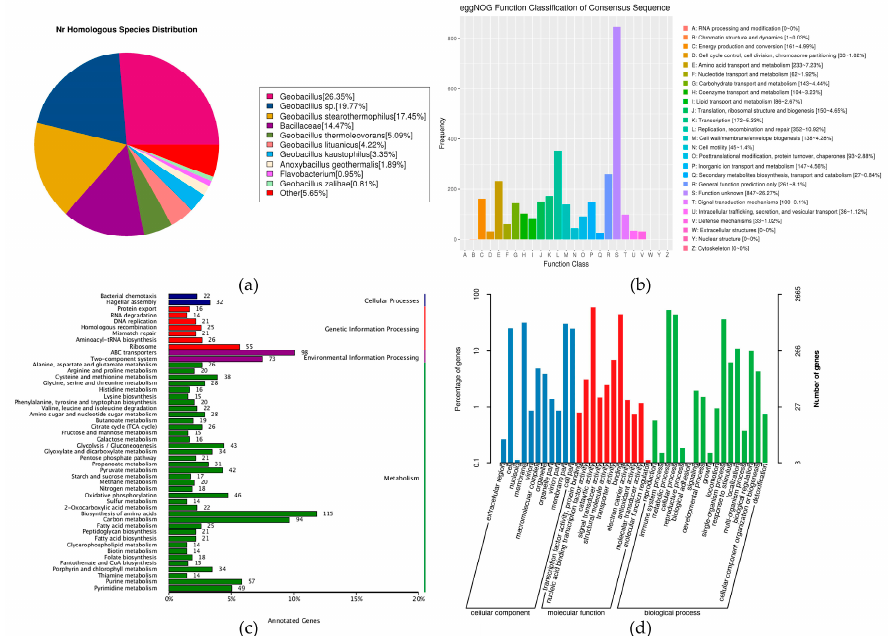
Figure 5. G. stearothermophilus H6 general protein prediction database: ( a ) Species distribution map of sequences compared to the Nr database: this map reflects the species distribution of the sequences compared to the Nr database. Different colors represent different species. ( b ) Statistical chart of the functional classification of eggNOG functional genes: the abscissa represents the classification content of eggNOG, and the ordinate represents the relative contents of the number of corresponding functional genes. ( c ) Statistical chart of KEGG annotation classifications: the ordinate represents the KEGG secondary classification, and the abscissa represents percentage. ( d ) Statistical chart of GO function annotation classifications: the abscissa represents the GO classification content, the left side of the ordinate represents the percentage of the number of genes, and the right side represents the number of genes. This figure shows the gene enrichment of each secondary GO function against the background of all genes, reflecting the status of each secondary function against this background.